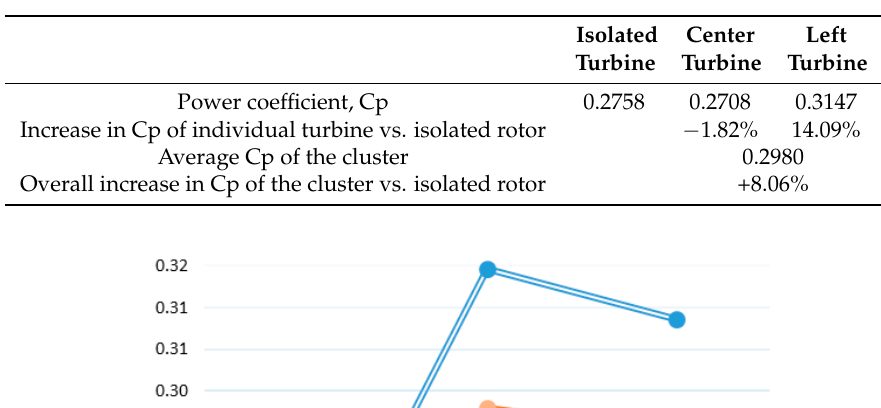
Figure 13. Velocity contours near the left, right and center turbine.